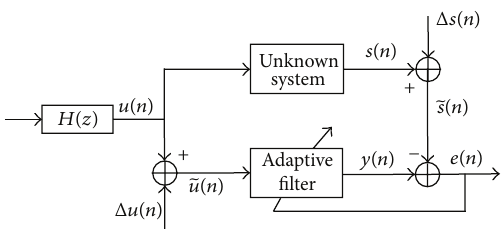
Figure 2: An unknown system identification model for adaptive filtering of correlated noisy signals.